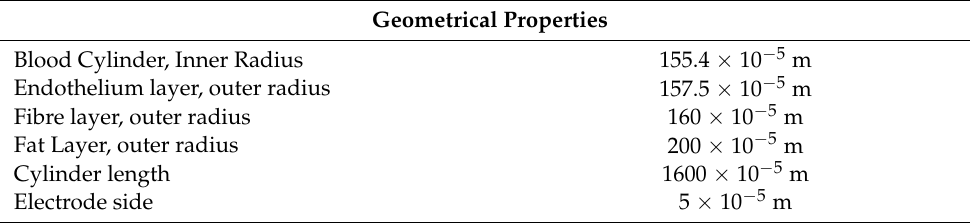
Table 1. Geometrical properties of the different layers